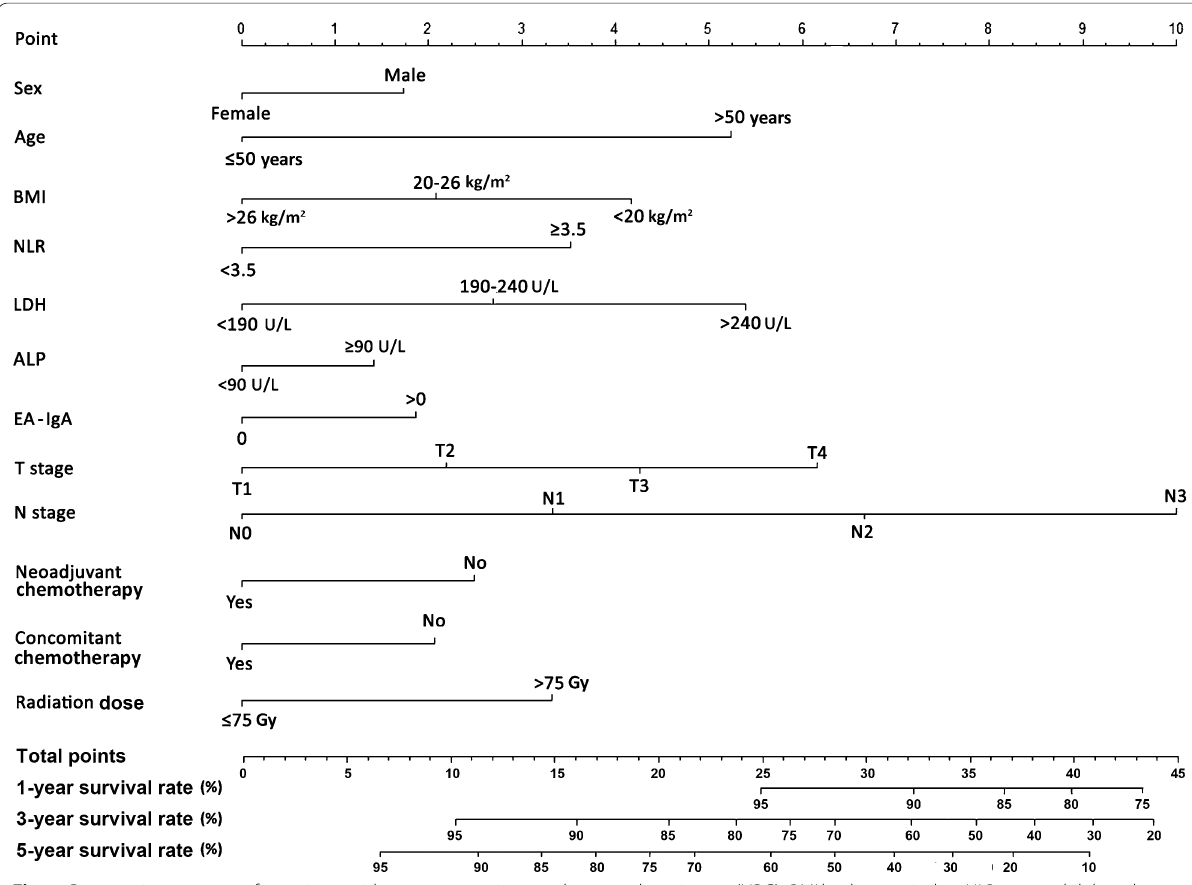
Fig. 1 Prognostic nomogram for patients with non-metastatic nasopharyngeal carcinoma (NPC). BMI body mass index; NLR neutrophil–lympho- cyte ratio; LDH lactate dehydrogenase; ALP alkaline phosphatase; EA-IgA immunoglobulin A against Epstein–Barr virus viral early